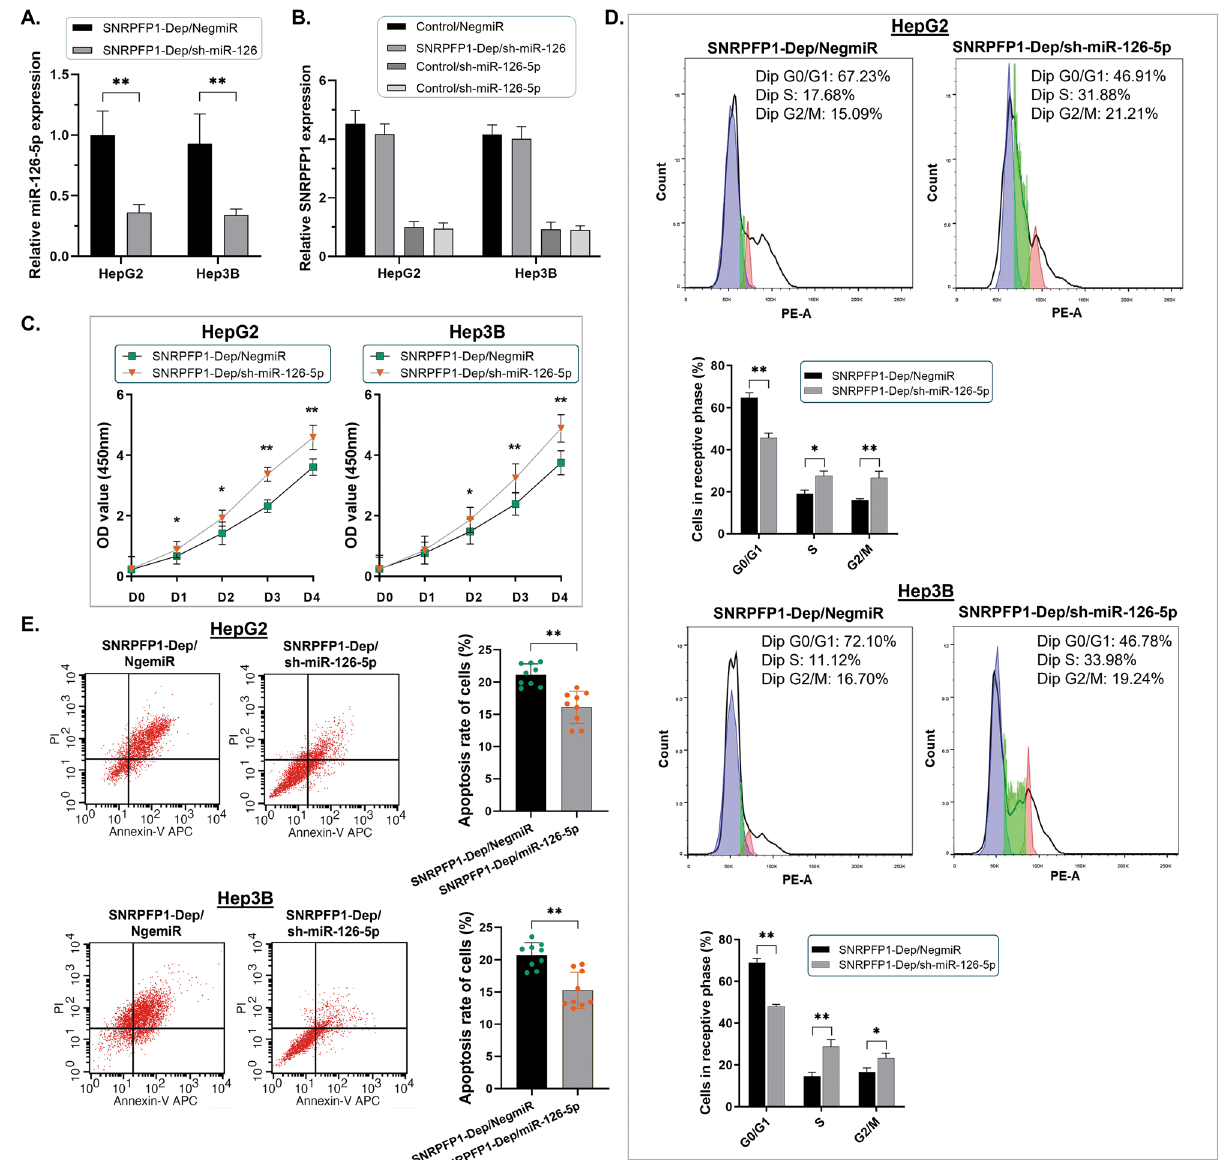
cell lines of both HepG2 and Hep3B cells (** P < 0.01). ( B ) The RT-qPCR assay indicated no significant change in the expression of the SNRPF gene when miR-126-5p was depleted in the HepG2 and Hep3B cells. ( C )